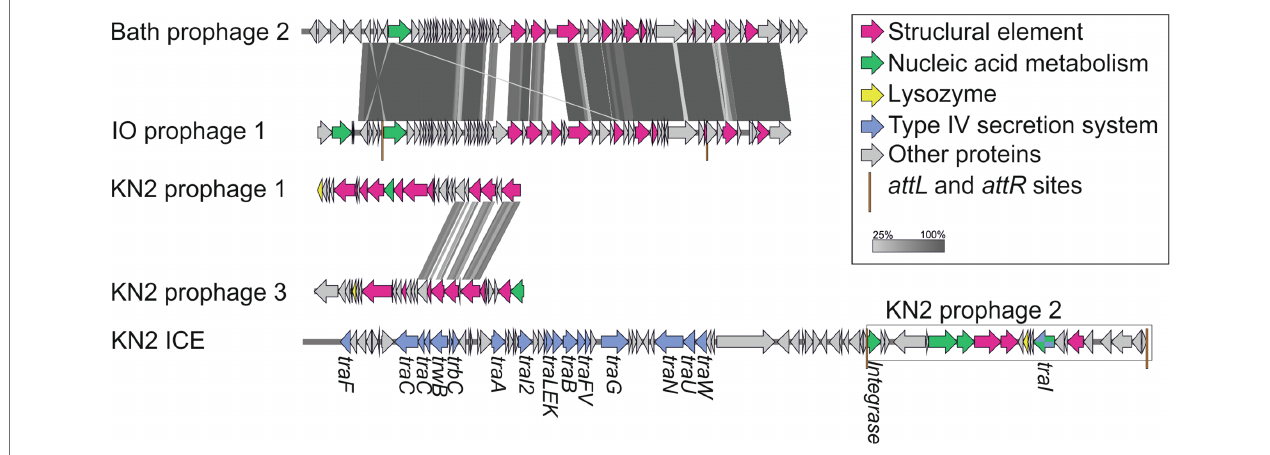
FIGURE 8 | The structure of integrative and conjugative element (ICE) region revealed in the genome of strain KN2 and prophage-associated regions ( ≥ 20 Kb) detected in the examined Methylococcus genomes.